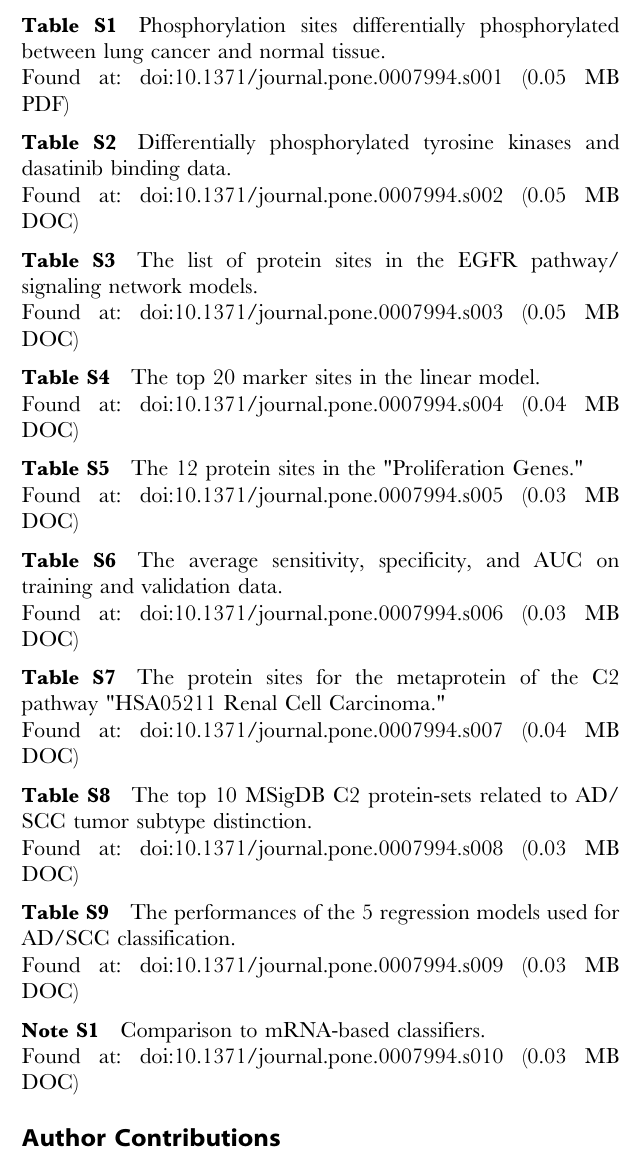
Table S1 Phosphorylation sites differentially phosphorylated between lung cancer and normal tissue.